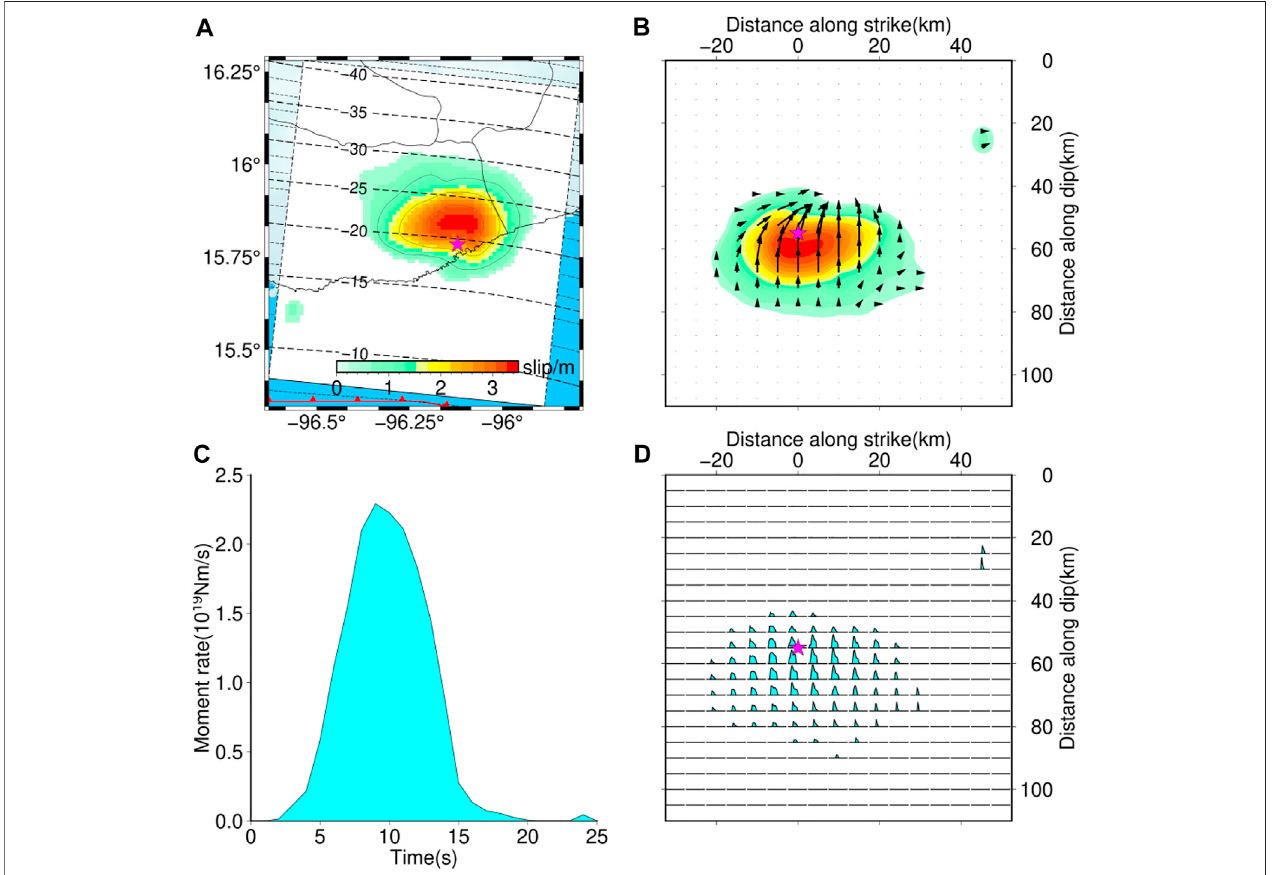
FIGURE 6 | Finite-fault results of the 2020 Oaxaca earthquake from joint inversion. (A) Surface projections of fault slip distribution; the magenta stars denote the epicentrallocation. (B) Slipdistributiononthefaultplane,theblackarrowdenotestheslipdirectionofeachsubfault. (C) Sourcetimefunction(STF)ofthisearthquake. (D) Subfault source time functions of each subfault on the fault